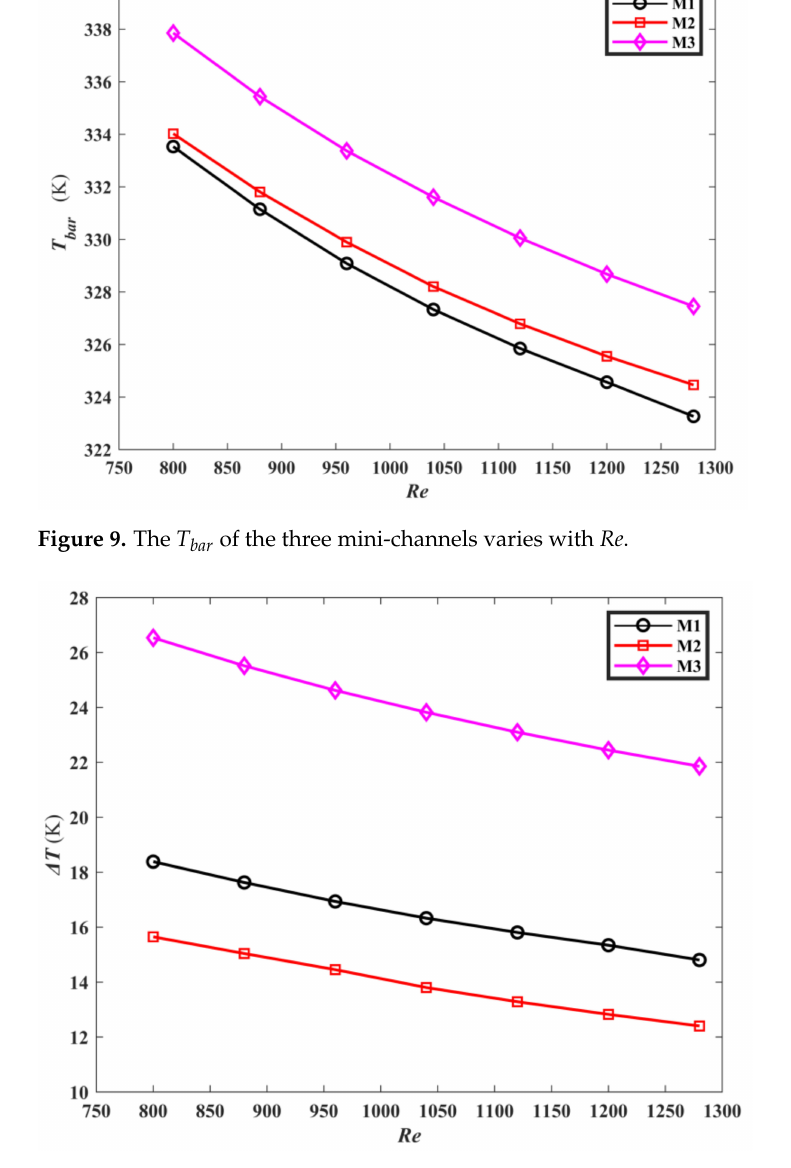
Figure 10. The ∆ T of the three mini-channels varies with Re